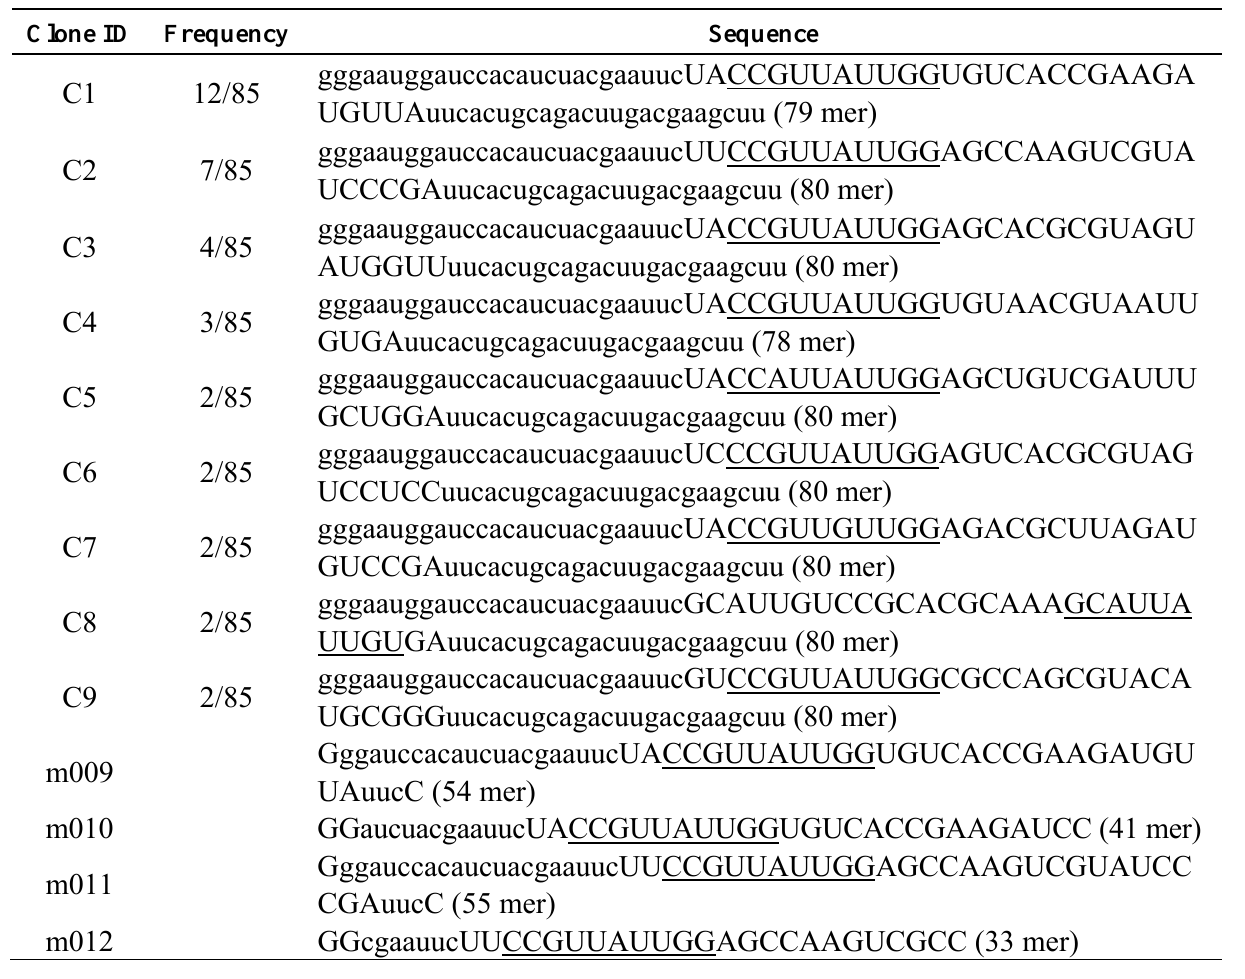
Table 1. Sequences of the SPC aptamers (C1–C9) and their truncated variants. Lower case letters indicate nucleotides derived from the fixed sequences. The conserved hairpin motif is